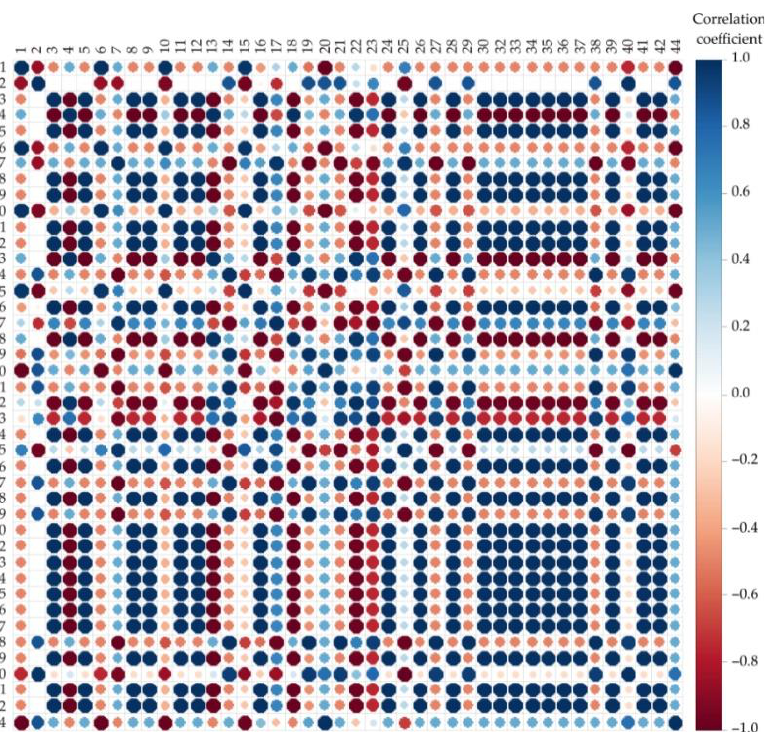
Figure 3. Correlation between volatile compounds of S. officinalis hydrolate (the compounds were codded according to Table 5). The PCA of the relations between the volatile compounds of S. officinalis hydrolate explained that the first two principal components summarized 100% of the total variance in the 44 parameters (volatile compounds). The first PC explained 59.18% and the second 40.82% of the total variance between the experimental data. The parting within samples could be seen from the PCA Figure 4, where the volatile compounds of S. officinalis hydrolate during 2019 are assembled on the left, 2020 on the right, and 2021 on the bottom side of the graphic.